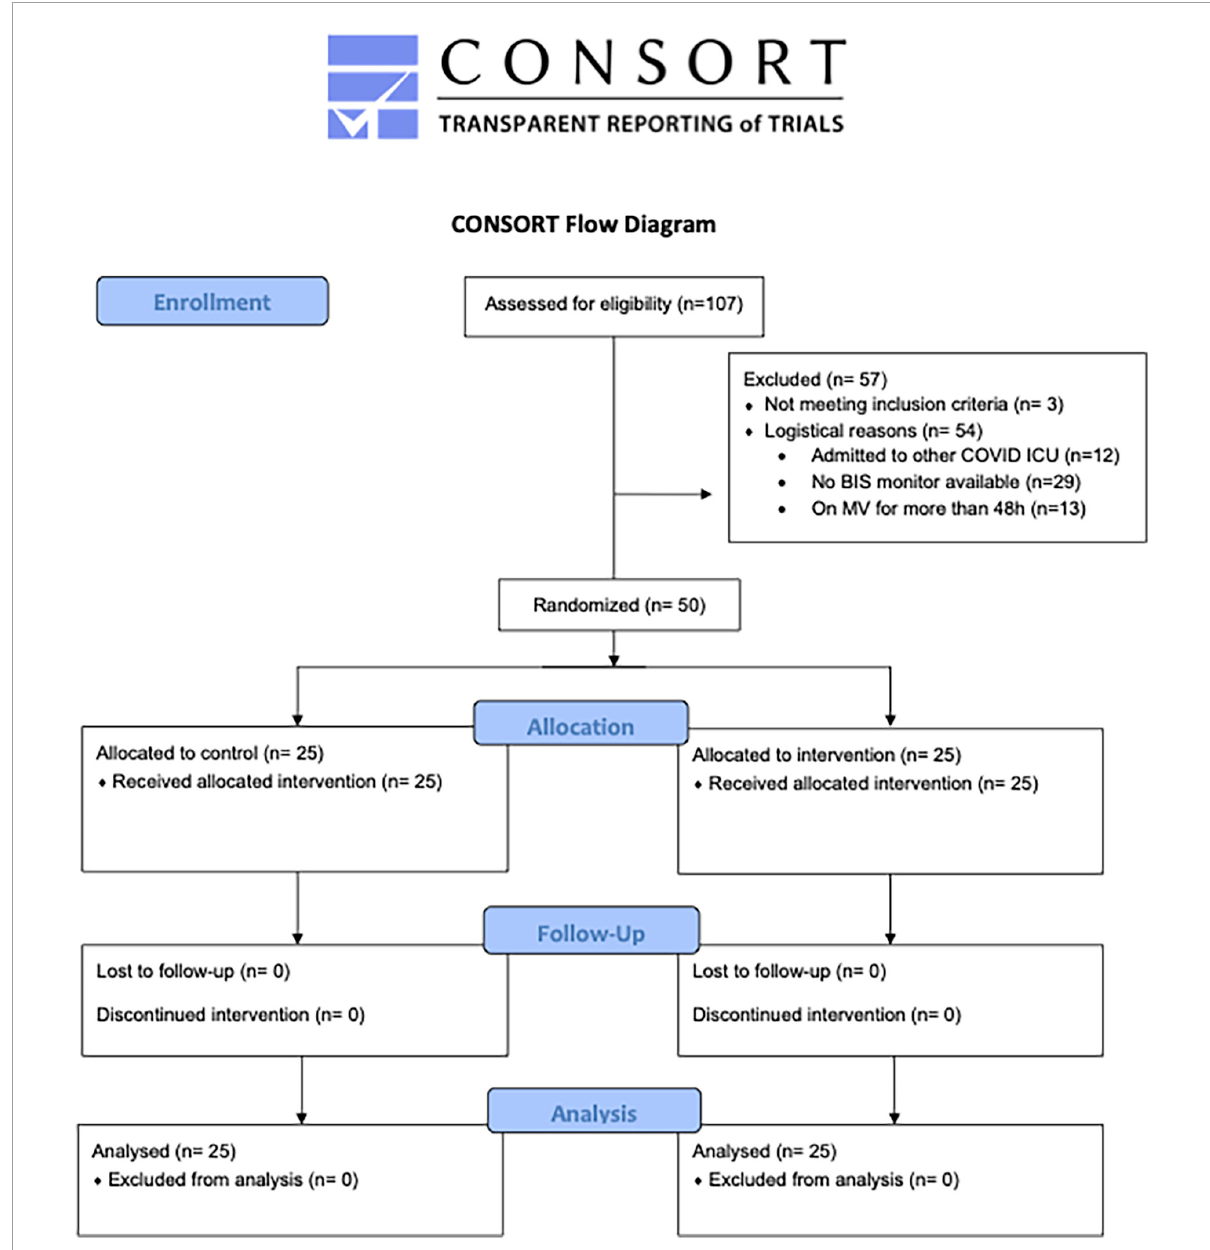
FIGURE1 Consort flow chart of the study. COVID, coronavirus disease; ICU, intensive care unit; BIS, bispectral index; MV, mechanical ventilation